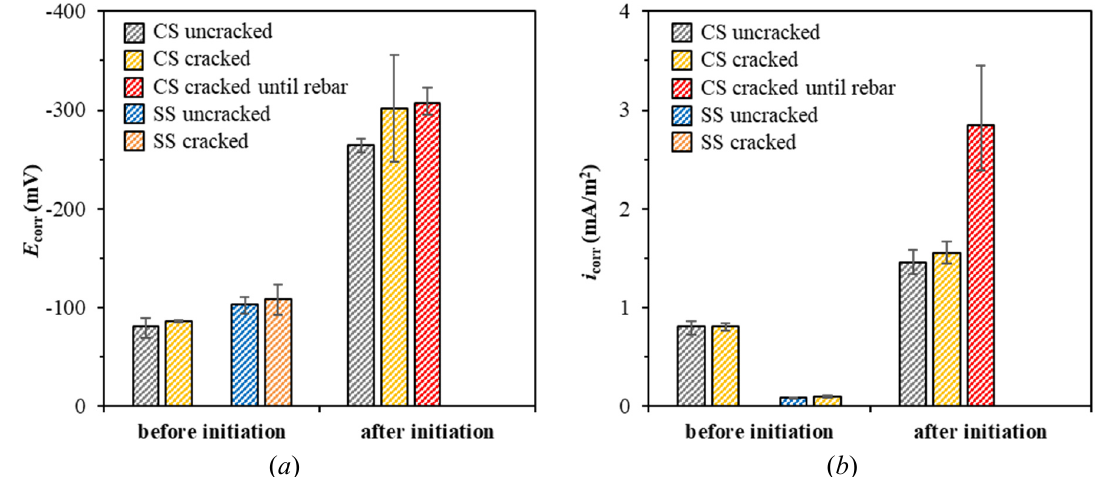
Figure 4. Average values of the corrosion potential (a) and corrosion current density (b) before and after initiation of corrosion for all the replicate specimens.